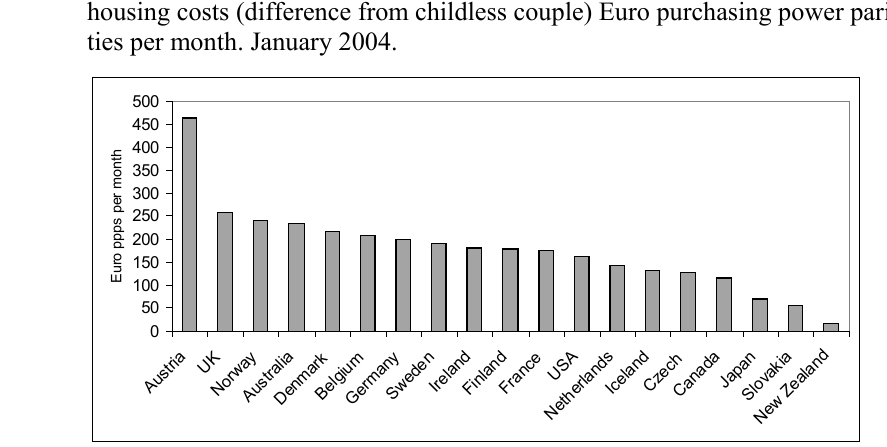
Figure 22 : Overall “average” child benefit package after taxes, benefits, childcare and housing costs (difference from childless couple) Euro purchasing power pari- ties per month. January 2004.